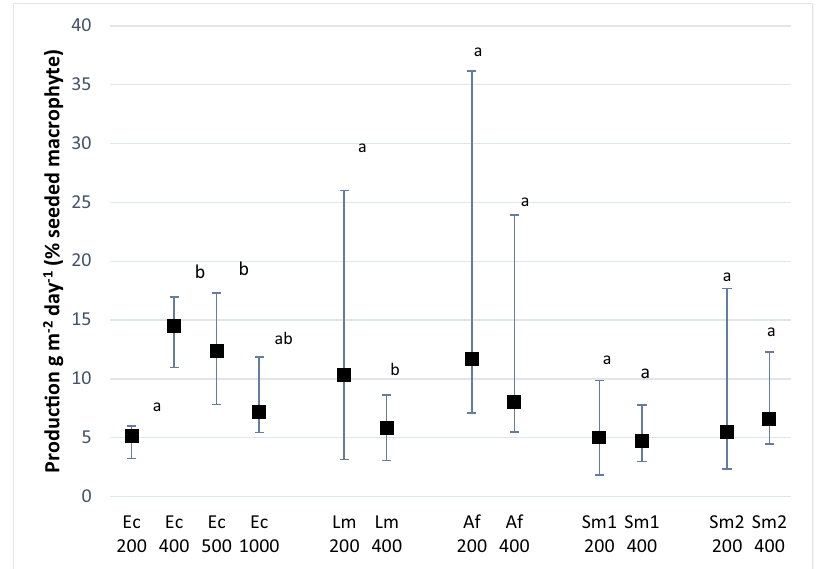
Fig. 1. Production (gm (cid:3) 2 day (cid:3) 1 ) in % seeded macrophytes according to level of seeding. Lm: Lemna minor ; Af: Azolla fi liculoides ; Sm1: Salvinia molesta type1; Sm2: Salvinia molesta type 2; Ec: Echhornia crassipes . Data are expressed as the median and 25% and 75% quartiles. Treatments with the same letter indicate no difference between seeding levels for a given taxon ( P = Kruskal – Wallis ANOVA on ranks for Ec; Mann – Whitney rank sum test for all other